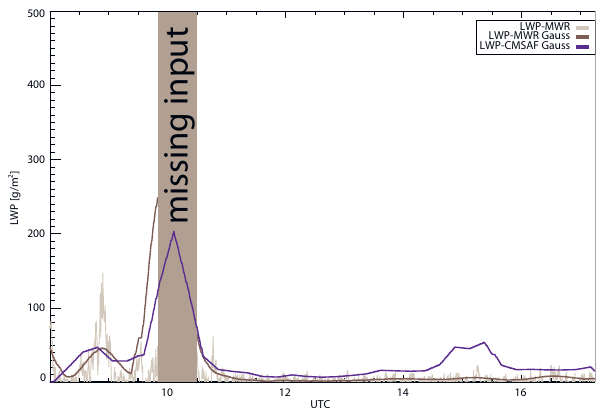
Fig. 1. Liquid Water Path for 3 November 2007. Ship based mi- crowave radiometer LWP (blue, LWP-MWR Gauss), averaged with a Gaussian weighting function (30min half max/full width) over all measurements with LWP > 0 and multiplied by the cloud fraction. CM SAF LWP (dark grey, LWP-CMSAF Gauss) averaged using spatial Gaussian weighting function (3 pixels half max/full width). In light grey is shown the full-resolution ship based microwave ra- diometer LWP as indicator for the variability.